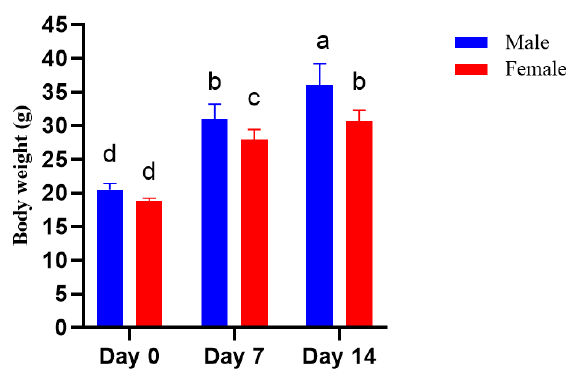
Figure 3. Body weight of mice supplemented with emu oil in the acute toxicity test. Letters on the bar within the same form of emu oil indicate significant differences ( p < 0.05).